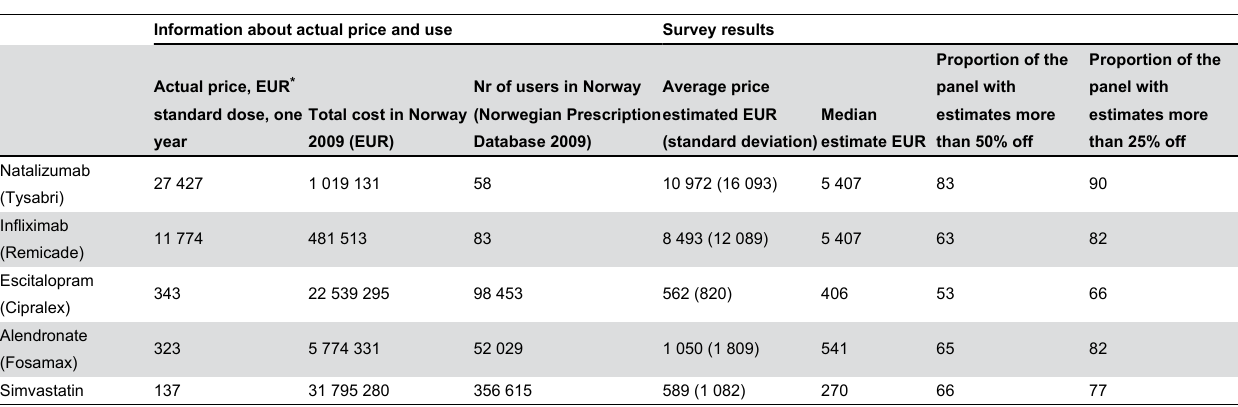
Table 2. Summary statistics, price estimates.